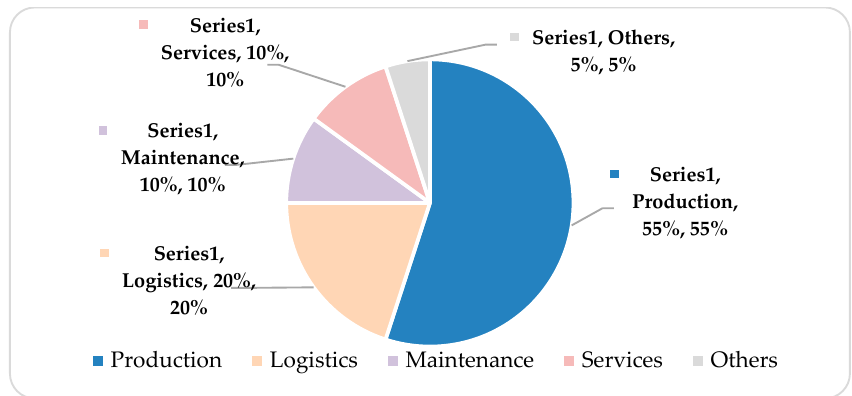
Figure 5. PSA Group SVK automation areas. Source: Authors’ compilation.